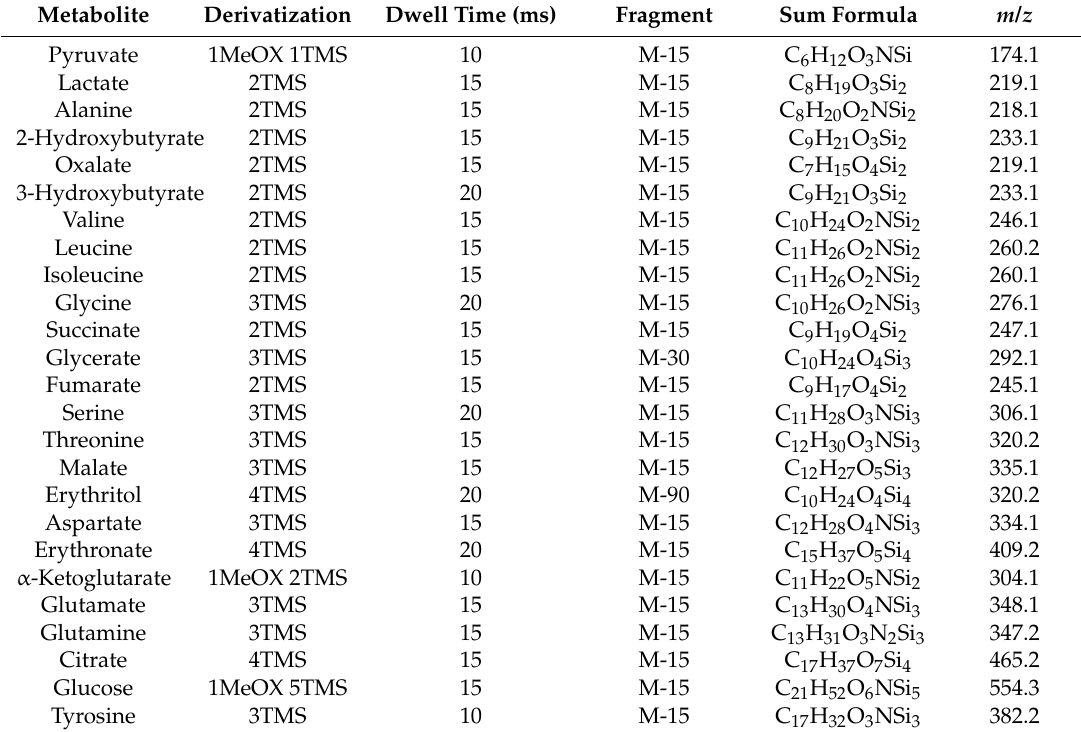
Table 3. Settings applied in selected ion monitoring (SIM) mode for the detection of the target metabolites.